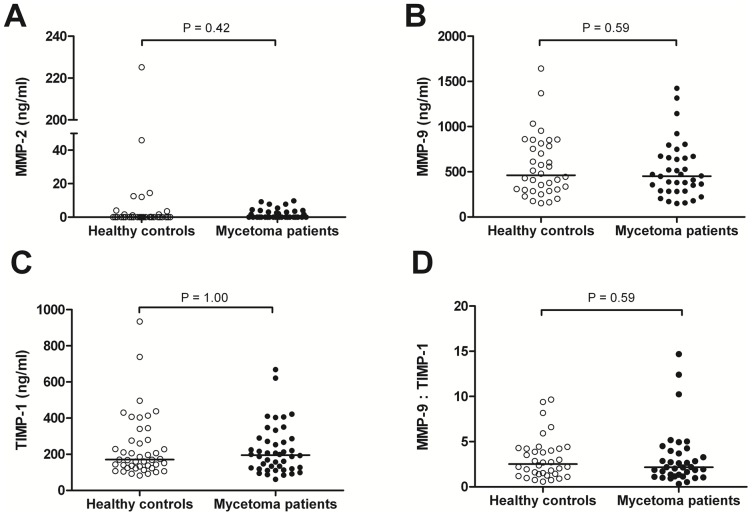
Concentrations of MMP-2 (A),MMP-9 (B), TIMP-1 (C), and MMP-9:TIMP-1 ratios (D) in sera of M. mycetomatis infected subjects and healthy endemic controls.Data is presented as median. Each dot represents the serum concentration or ratio of each (inhibitor of) metalloproteinases of one patient or healthy control. Significance was determined by Mann-Whitney test.